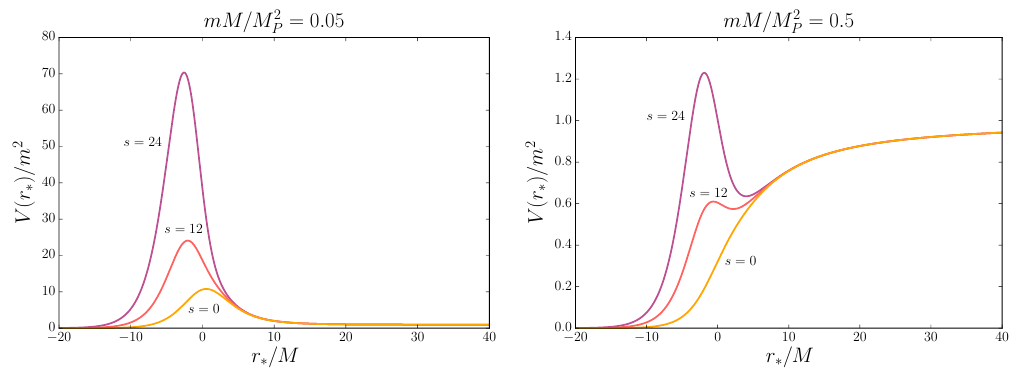
Figure 3 . The e(cid:11)ective potential V ( r (cid:3) ) from eq. (4.16) against r (cid:3) , for three choices of s , charac- terising the strength of the tidal term. On the left is this potential in the low-mass regime, and on the right with a mass close to the critical mass m c 0 : 385 =M . The e(cid:11)ect of the tidal terms is ’ to either produce or enhance a potential barrier through which the particle must tunnel, thereby reducing the probability of